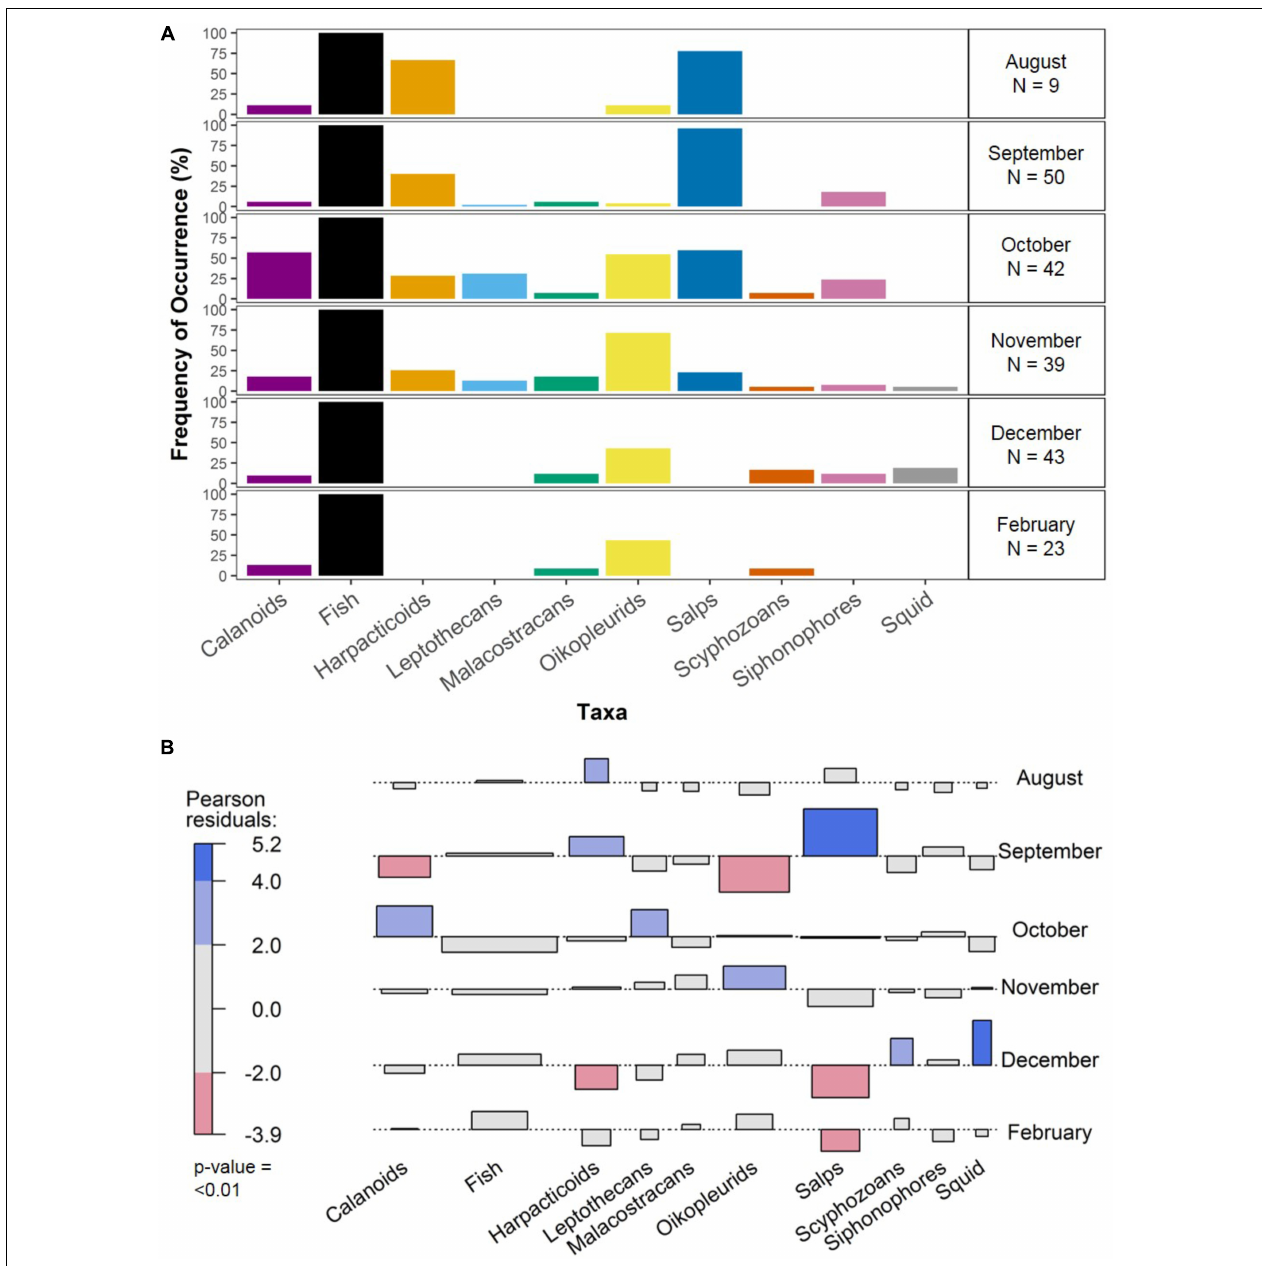
FIGURE 2 | The frequency of occurrence (%) of the 10 most common taxa in fecal samples over surveyed months of the breeding season. The percentages for each taxon over months are shown along with number of samples per month (A) and the association plot (B) illustrates significant differences between observed and expected numbers of samples containing taxa in each month, based on Pearson residuals. Red or blue shading indicates significance level. Light shading indicates p -values between 0.05 and 0.01, while bold shading indicates p -values < 0.01. In our analysis, we have accepted only significant values less than 0.01. Note that January was not incorporated in analyses due to insufficient sample